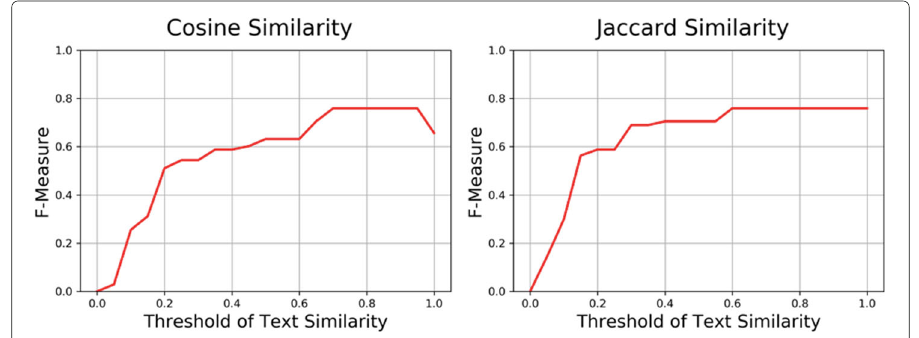
Fig. 6 Optimal threshold for cosine similarity and Jaccard similarity models